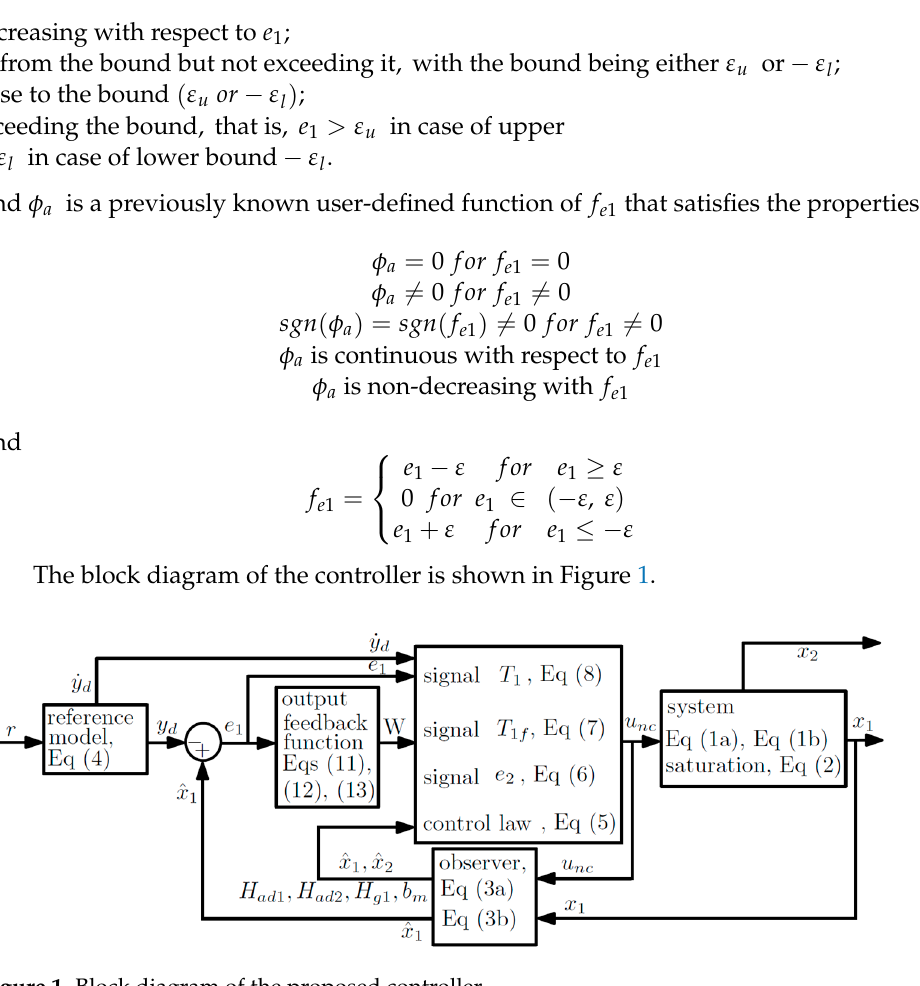
Figure 1. Block diagram of the proposed controller.